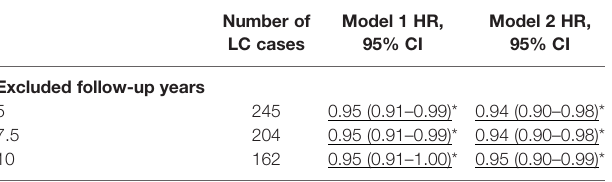
TABLE 3 | Hazard ratio ’ s (95% CI) for BMI (kg/m 2 ) with the risk of lung cancer after excluding lung cancer cases during the fi rst 5, 7.5, and 10 years of follow- up after baseline